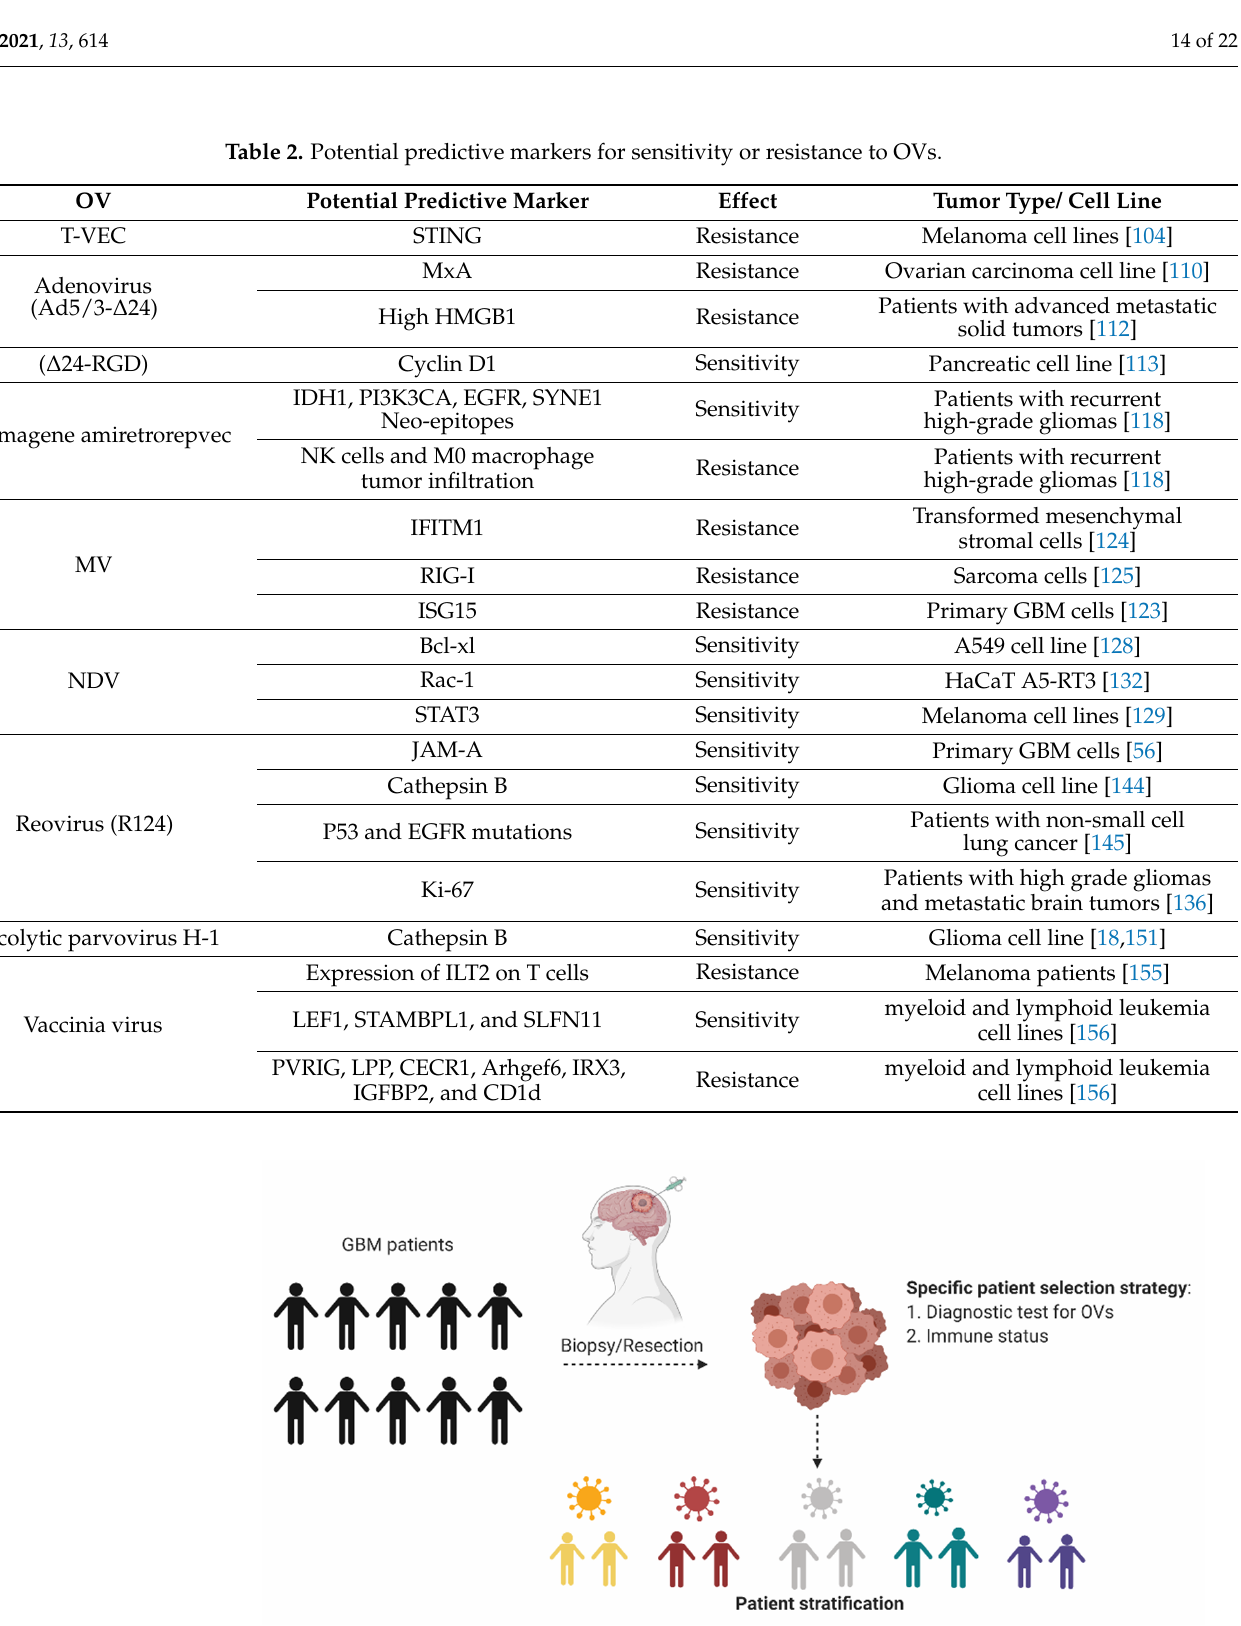
Figure 2. Personalized oncolytic virotherapy. In an envisioned personalized OV trial, resected tumor material from each patient would be used for diagnostic tests to identify the most potent OV, in terms of oncolysis for the particular tumor. Additional tests to determine local and/or systemic immune status after OV infection could further aid in stratifying the patients based on their unique tumor microenvironment and immune status. Created with BioRender.com.